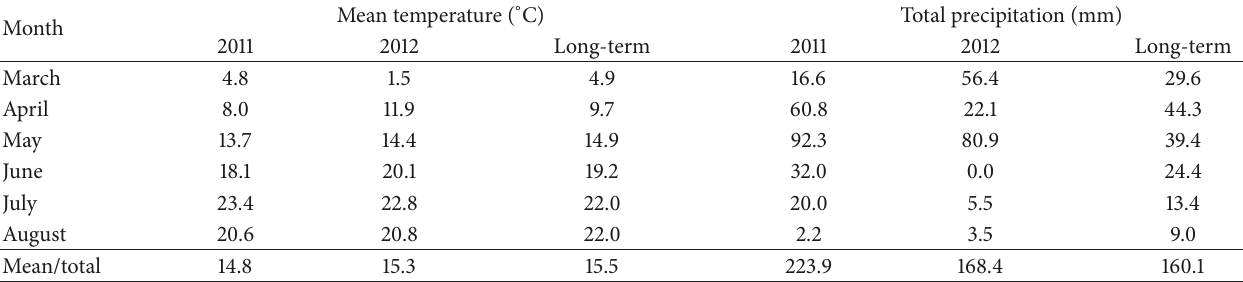
Table 1: Monthly climatic data of the experimental field and long-term average during growing